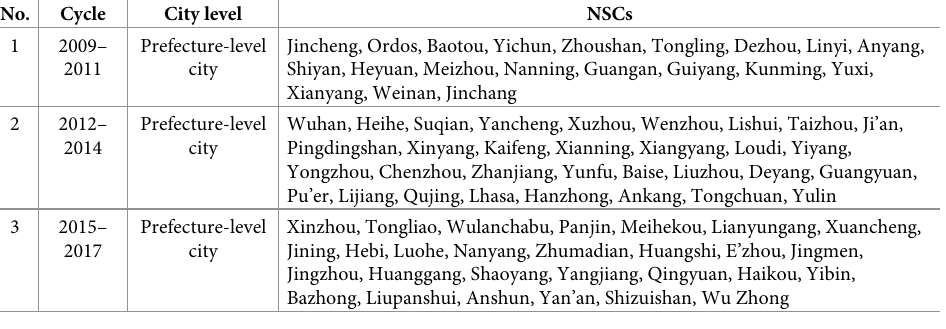
Table 1. The NSCs in the first three cycles published by the NPHCC after 2008. No. Cycle City